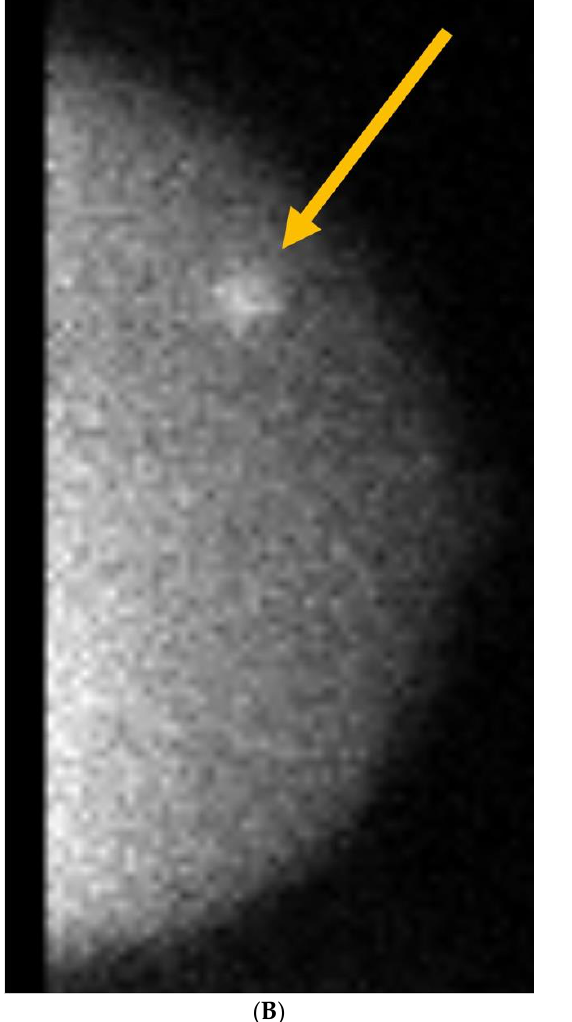
Figure 9. Courtesy of Drs. Deborah Rhodes and Carrie Hruska. Negative mammogram in a woman post lumpectomy. ( A ) cc views, routine and spot magnification. Tomosynthesis (not shown) was also negative. Notably, the breast is category B, not dense. ( B ) Recurrent carcinoma (arrow) detected on MBI ( C ) Targeted US demonstrates the cancer.